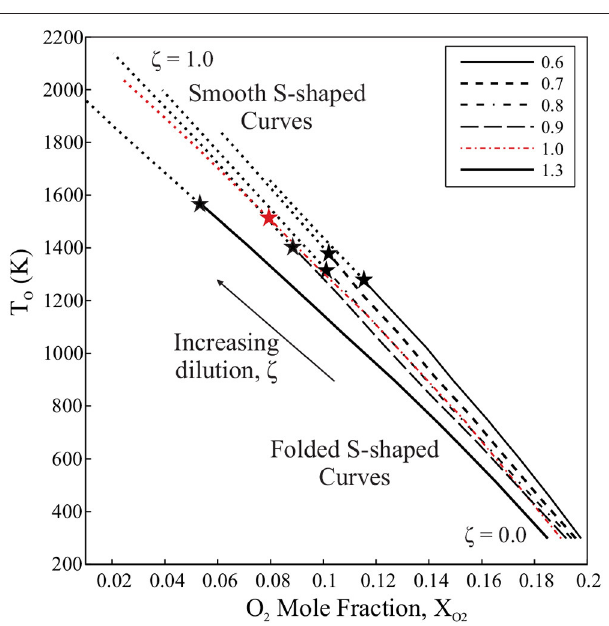
FIGURE 5 | S-Shaped Curve behavior for mixtures of increasing hot product dilution, ζ based on the mixing procedure of Sidey et al. (2014). Patterned, bold lines mark regions where mixtures satisfy the condition for a folded S-Shaped Curve, while dotted lines regions where mixtures fail to satisfy Equation 20, suggesting smooth S-Shaped Curve behavior. The “ ⋆ ” symbols mark the point of transition from folded to smooth S-Shaped Curves.